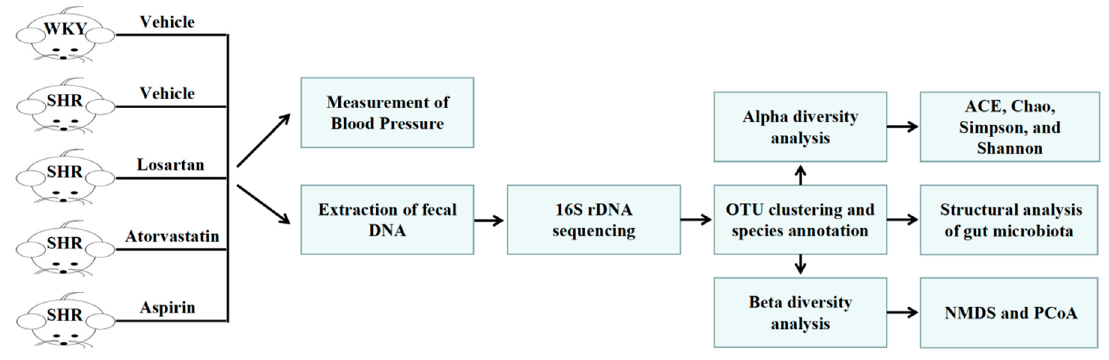
Figure 10. Experimental flow chart of this study.